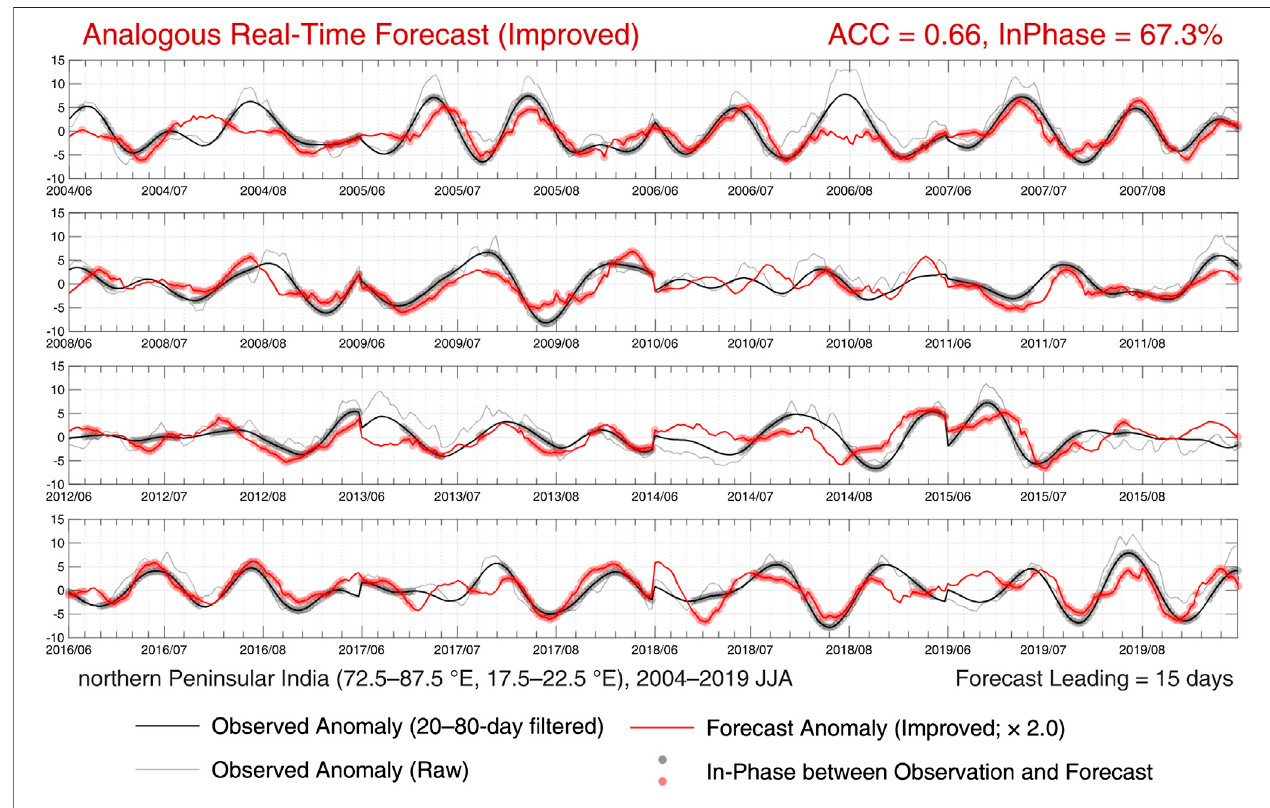
FIGURE8| Same asin Figure 5 , but the forecast anomaly and the instantaneousphase estimation at each point areobtained fromthe constructed time-series of KB (cid:2) 15 and KF (cid:2) 15, processed by a 20-day low-pass VMD fi lter (see the text for details).